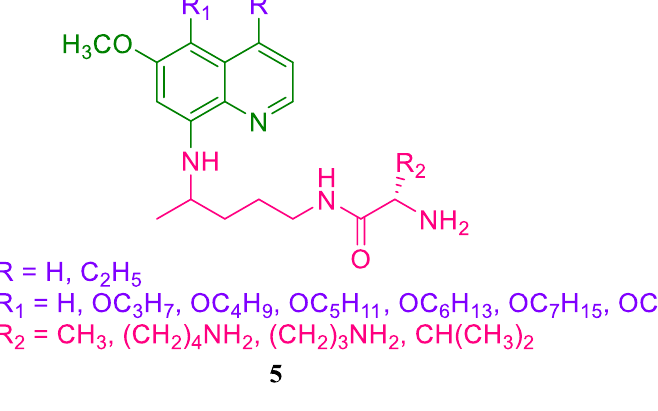
Figure 15. 8-quinolinamine-amino acid conjugates.